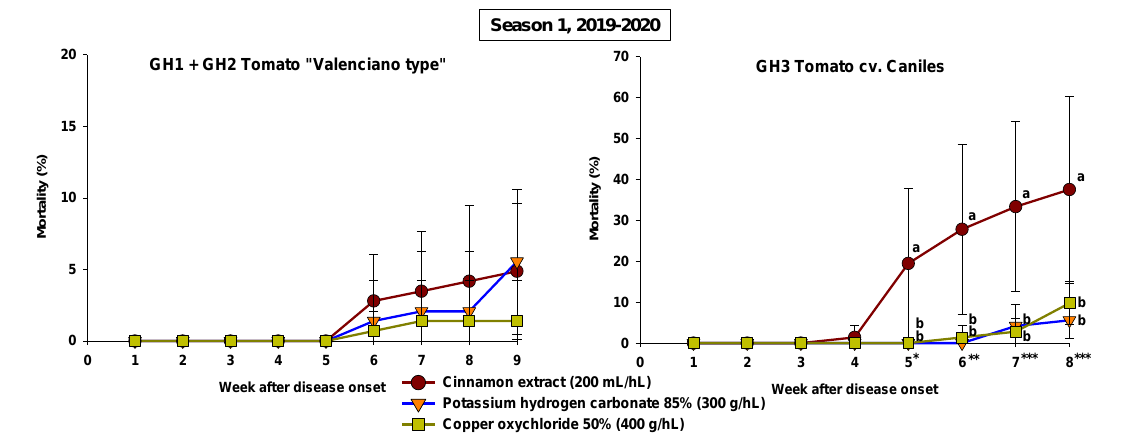
Figure 5. Accumulated mortality of “Valenciano - type” and cv Caniles tomato plants due to grey mould for Season 1 depending on treatment. Values are mean ± standard deviation; n=4. Different letters in the same week indicate significant differences ( p ≤ 0.05, Fisher’s LSD test). “*”, “**”, and “***” indicate significance at p ≤ 0.05, 0.01, and 0.001, respectively. Note: in Year 2, there was no tomato plant mortality due to grey mould. Table 5. Marketable production in the different trials for the different